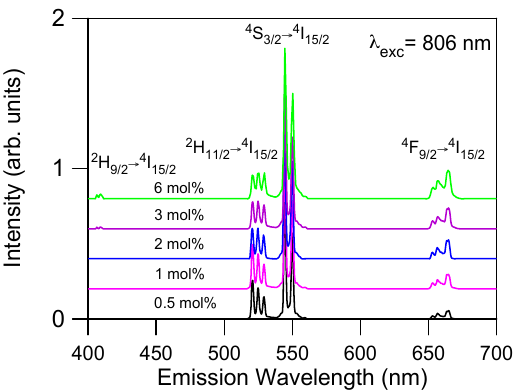
Figure 3. Room temperature upconversion emission spectra under excitation at 806 nm for all concentrations. Spectra have been shifted vertically to ease comparison.